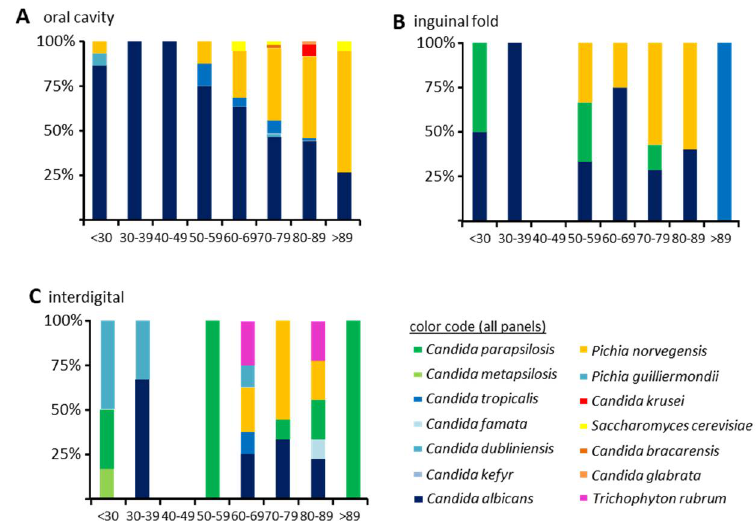
Figure 2. Species stratified by host age. The percentage of individuals colonized in different age groups is given. Oral ( A ), inguinal fold ( B ), and interdigital ( C ) specimens. Color code corresponds to the one used in Supplementary Figure S1.